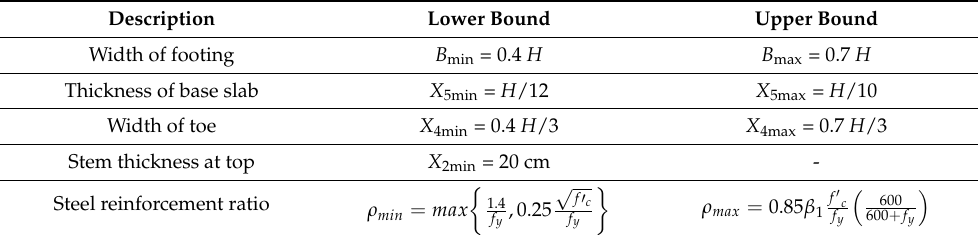
Table 13. Upper bound and lower bound for design variables of retaining wall.